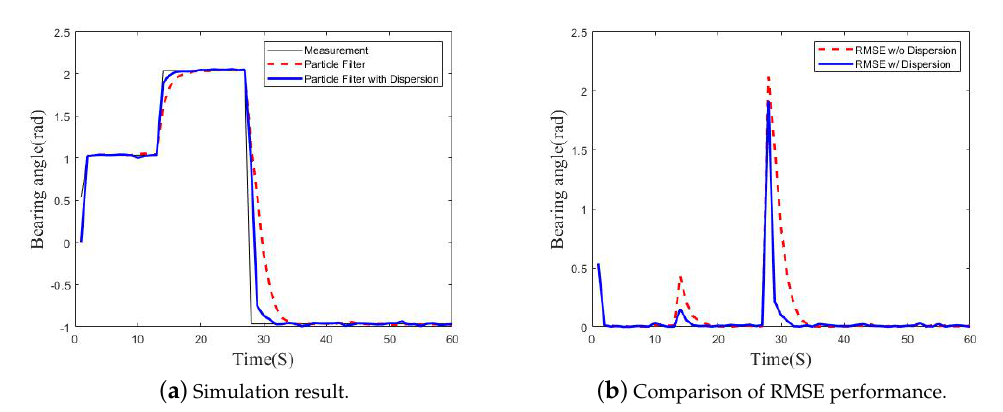
Figure 3. Performance of particle filter with sample dispersion.